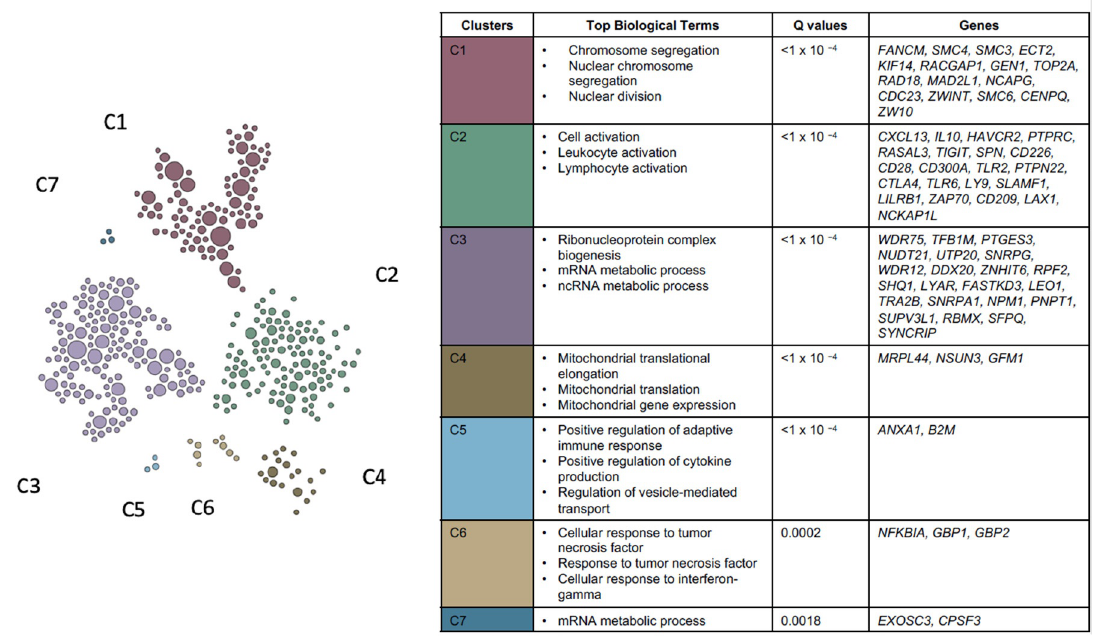
Figure 6. Genome scale integrated analysis (GIANT) used to detect cohesive gene clusters from the 555-overlapping CMS1 gene signature list. Genes within a cluster share local network neighborhoods. From the 555 overlapping genes, seven functional clusters (C1–7) were detected from the top significant genes with their reported top biological processes.